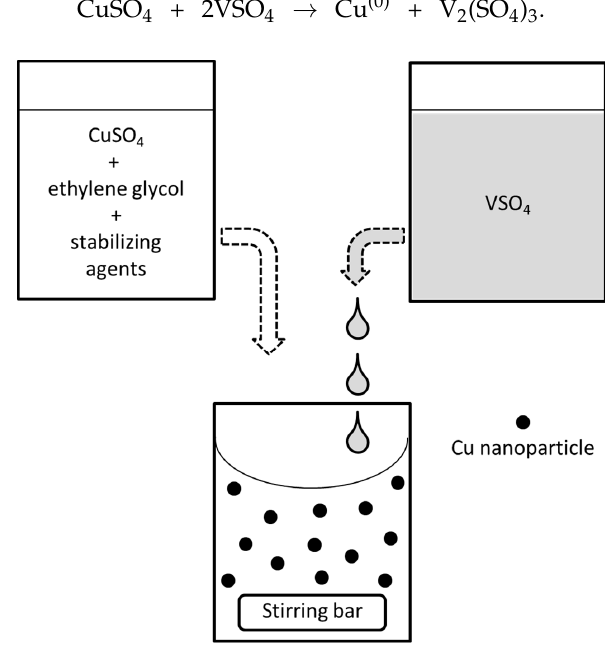
Figure 5. Scheme of the process here adopted for the synthesis of Cu-NPs.